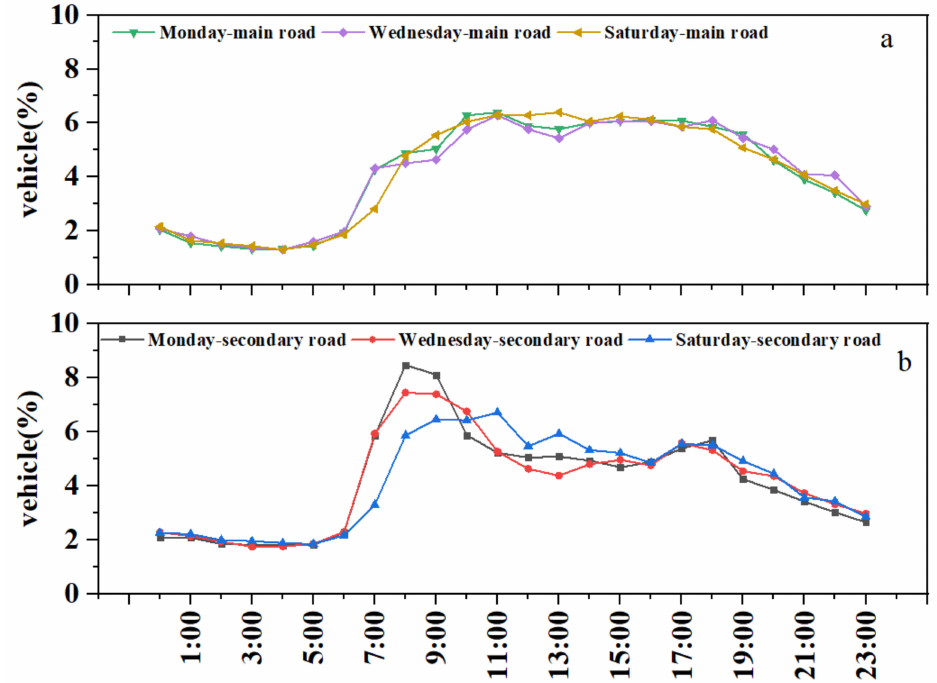
Figure 8. Average diurnal coefficient variations of traffic flow during the week in Shenyang for 2018 on ( a ) main and ( b ) secondary